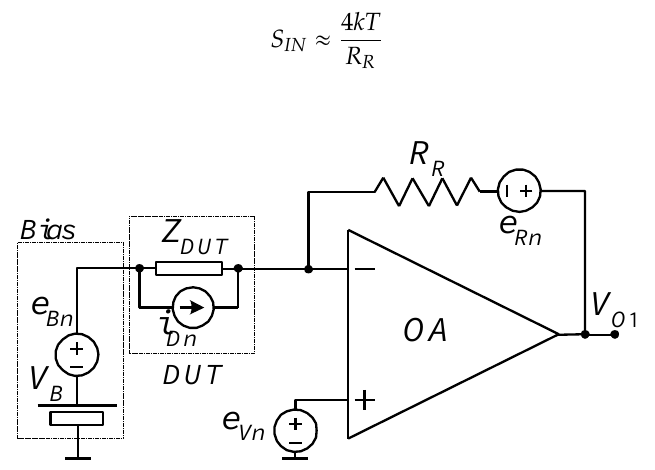
Figure 13. Reference circuit for current noise measurements.